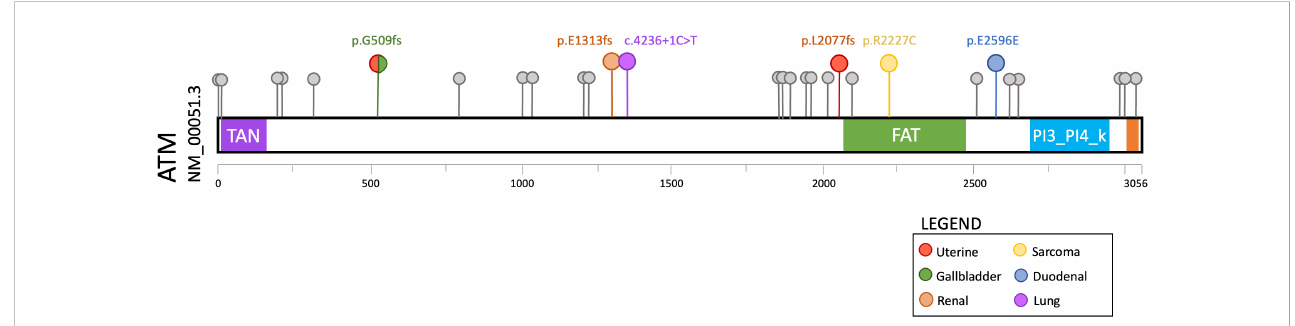
FIGURE 1 Lollipop plot of germline ATM pathogenic variants detected in 31 consecutive patients with a personal or family history of cancer who underwent hereditary cancer susceptibility testing. The six variants associated with cancers that are atypical for ATM hereditary cancer susceptibility are highlighted in color (see